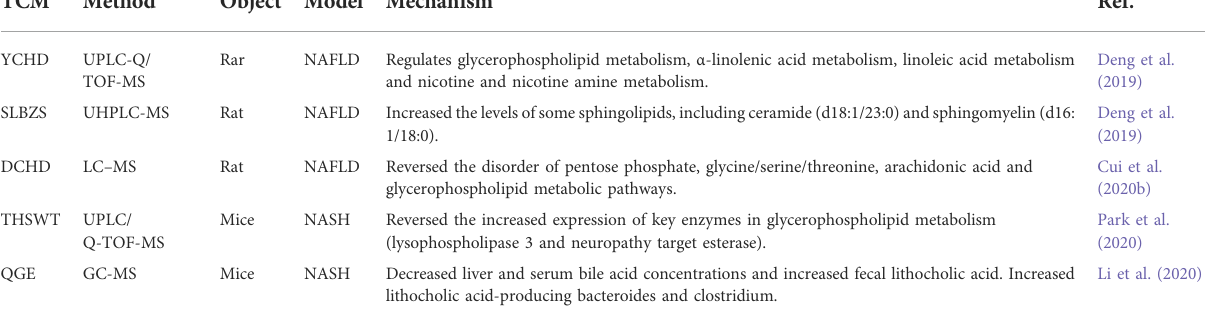
TABLE 2 The therapeutic effect and mechanisms of Chinese herbal formulas for